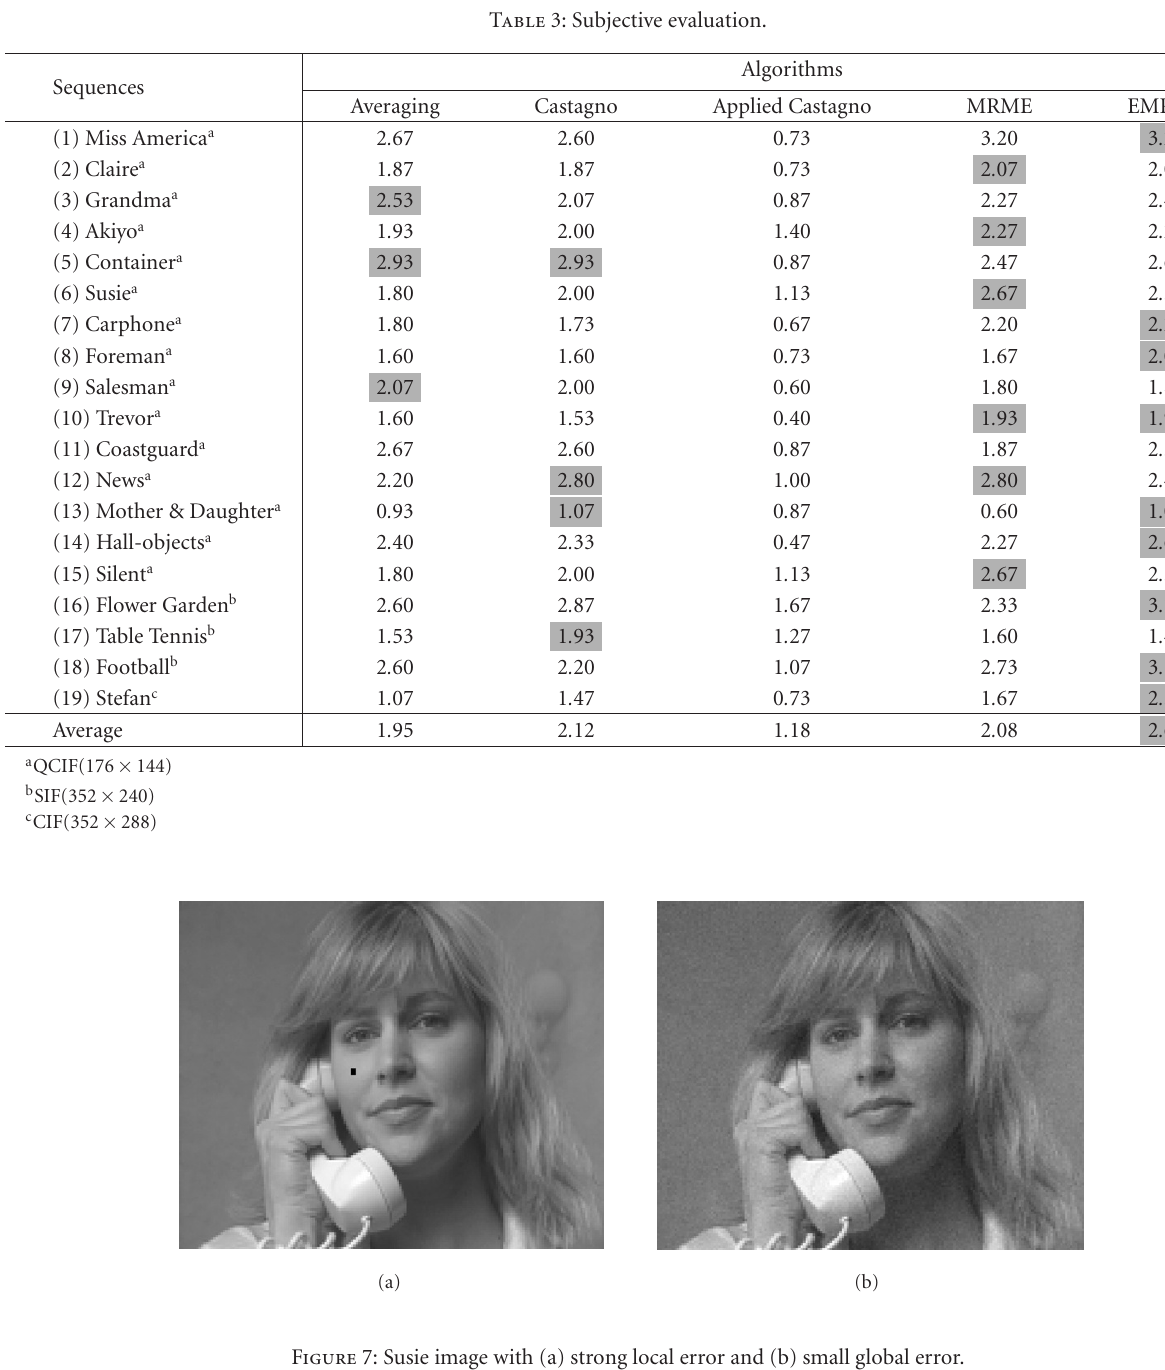
Figure 7: Susie image with (a) strong local error and (b) small global